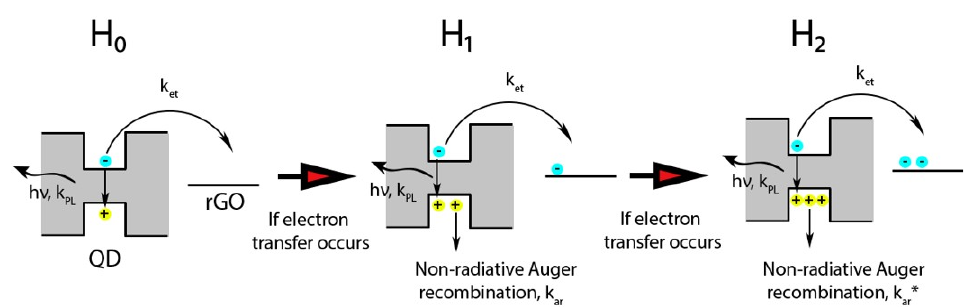
Scheme 1. Possible QD exciton relaxation pathways in the QD-rGO system. The circles with + sign depict the holes, the circles with − sign depict the electrons, the * after the k ar is to highlight the different rates in case of 2 excess